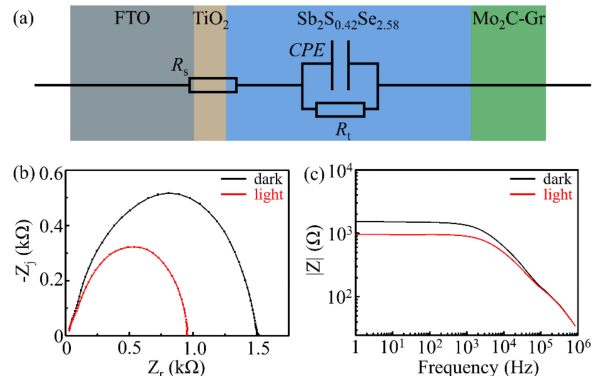
Figure 8. The impedance analysis of the photodetector. ( a ) The schematic equivalent circuit diagram of the Mo 2 C—Gr/Sb 2 S 0.42 Se 2.58 /TiO 2 /FTO photodetector. ( b , c ) Nyquist diagram and frequency-dependent relationships of the Mo 2 C—Gr/Sb 2 S 0.42 Se 2.58 /TiO 2 /FTO photodetector in the dark ( black ) and under illumination ( red ), respectively. CPE: constant-phase